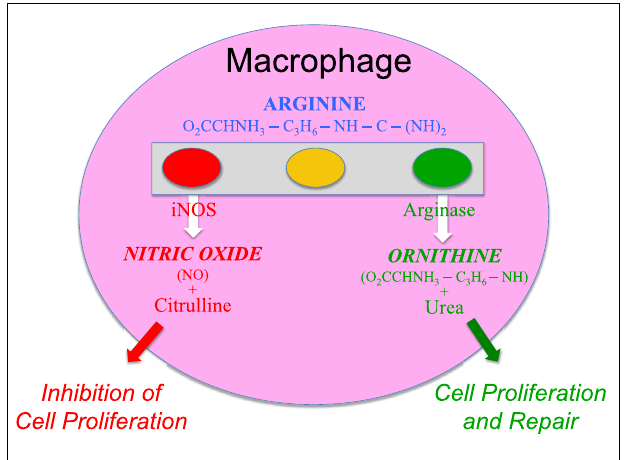
FIGURE 3 | Macrophages have both iNOS and arginase enzymes that can convert arginine to NO or ornithine, respectively . Products of each reaction inhibit the opposing reaction, promoting preferential NO or ornithine production.